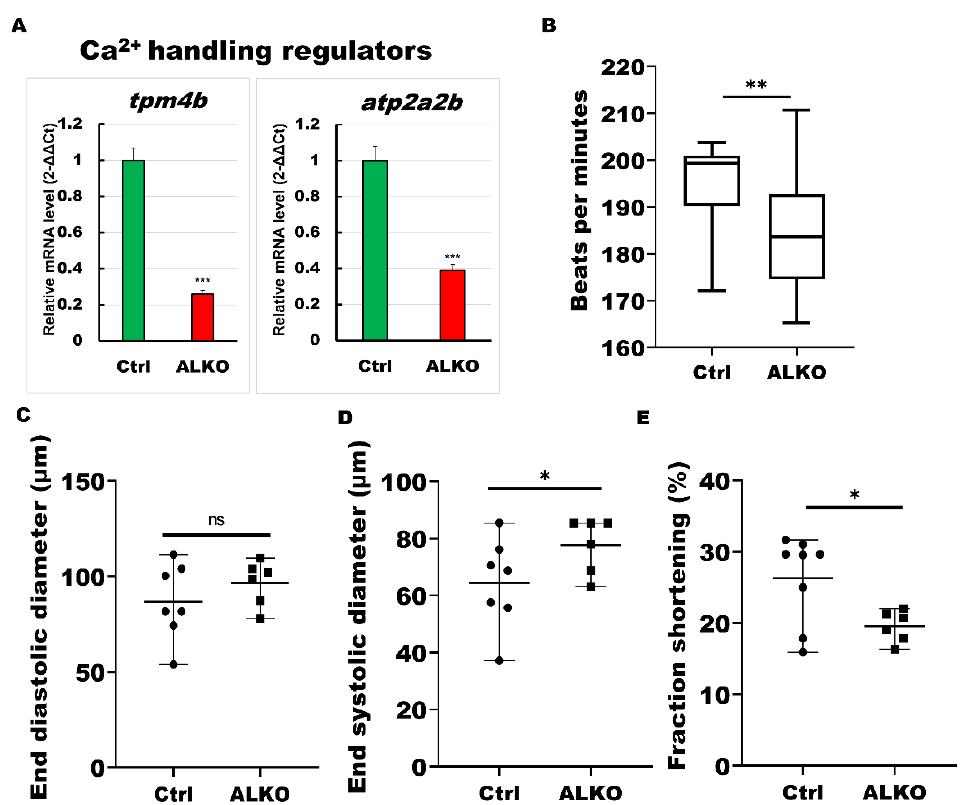
Figure 6. ALKO developed a dysfunctional heart. ( A ) RT-qPCR of ALKO ventricles at 5 mpf represented downregulation of calcium handling regulators: tropomyosin 4-2 ( tpm4b ) and ATPase sarcoplasmic/endoplasmic reticulum Ca 2+ transporting 2b ( atp2a2b ). In ALKO group, values of tpm4b = 0.258 ± 0.0201 and atp2a2b = 0.3882 ± 0.0341. ( B ) Heart rate assay revealing ventricle contraction. The heart rhythm analysis displayed impaired cardiac function in the ALKO compared to the control group at 120 hpf. Values of Ctrl = 194.538 ± 11.5407 and ALKO = 184.304 ± 13.0617. ( C ) End diastolic diameter showed no significant difference in ALKO group. Values of Ctrl = 86.7763 ± 19.9123 and ALKO = 96.595 ± 11.7485. ( D ) End systolic diameter increased in 120 hpf ALKO larvae. Values of Ctrl = 64.4851 ± 15.8247 and ALKO = 77.7095 ± 9.718. ( E ) The fraction shortening assay showed that the ALKO group exhibited a significant decrease compared to the control group. The fraction shortening, calculated as end-diastolic diameter (EDD) and end-systolic diameter (ESD), was measured in % as FS% = (EDD-ESD)/(EDD) × 100%. Percentage of Ctrl = 26.284 ± 6.1512 and ALKO = 19.5556 ± 2.185. Statistically significant differences from the controls are indicated by * p < 0.05, ** p < 0.01, and *** p < 0.001.